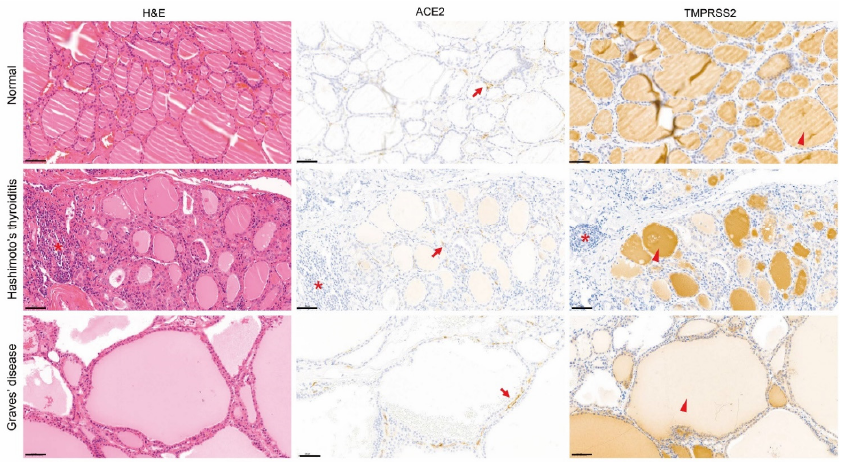
Figure 5. Immunolocalization of ACE2 and TMPRSS2 in the human thyroid. H&E staining (left panels), ACE2 staining (middle panels, brown), and TMPRSS2 staining (right panels, brown). In all three groups, including normal (top panels), Hashimoto’s thyroiditis (middle panels), and Graves’ disease (bottom panels), ACE2 was expressed only in the microvessels (arrow) between the follicles, but not in the follicular cells. TMPRSS2 was stained only in the colloid (arrowhead), although there was a difference in intensity in all three groups. Lymphocytes (asterisk) were observed in Hashimoto’s thyroiditis. The colloid was significantly greater in Graves’ disease than in the other two groups. Scale bar = 50 μ m. H&E, hematoxylin and eosin; ACE2, angiotensin-converting enzyme 2; TMPRSS2, transmembrane protease serine.